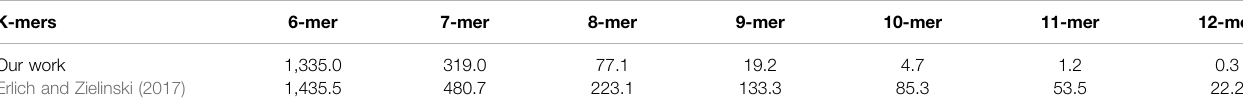
TABLE 1 | Jaccard similarity coef fi cient of two encoding schemes under different k − mers . K-mers Our work